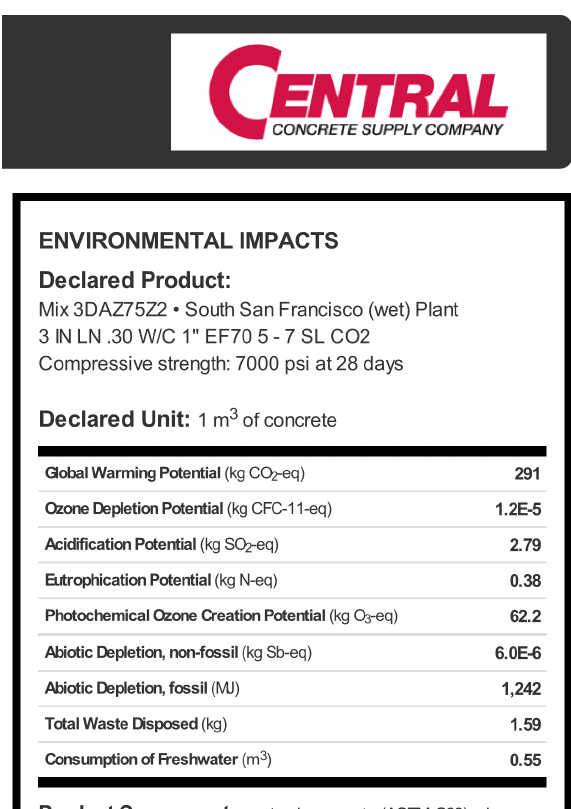
Figure 1. Example of the summary of environmental impacts from an EPD for a concrete mixture